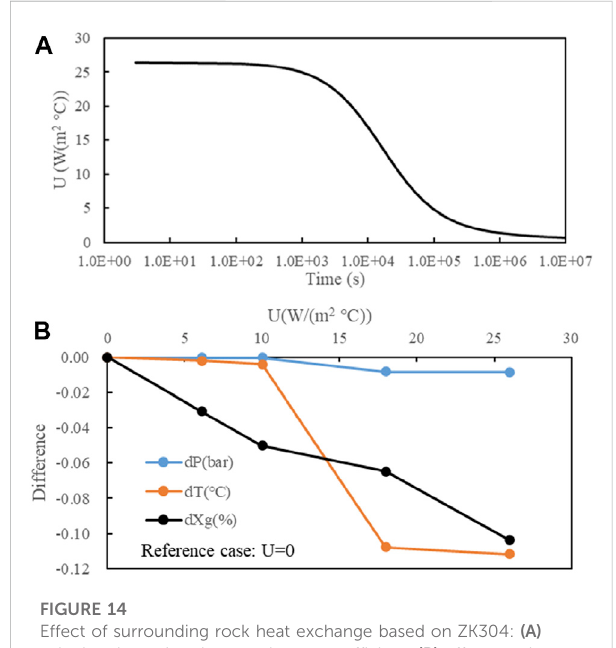
FIGURE 14 Effect of surrounding rock heat exchange based on ZK304: (A) calculated transient heat exchange coef fi cient, (B) effect on the wellhead performance